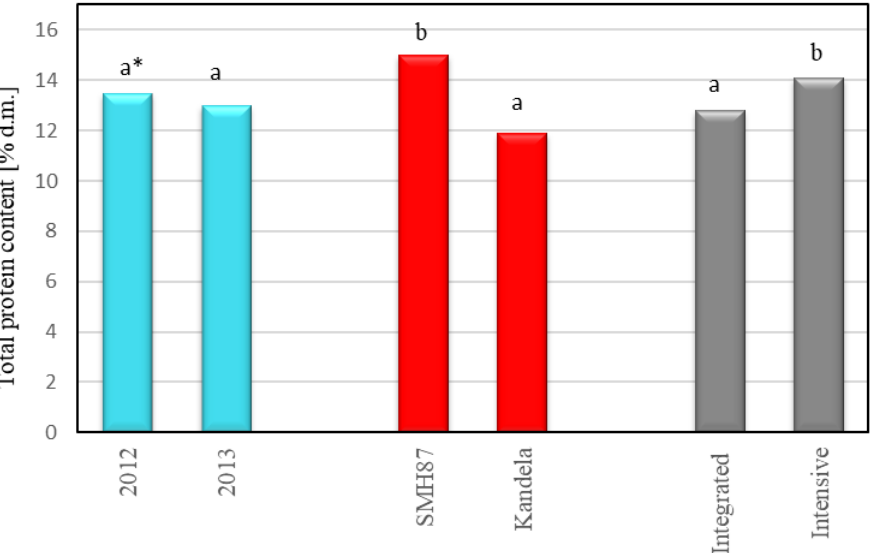
Figure 2. Total protein content of wheat grains in relation to harvest year, cultivar and production technology. * Different letters (a, b) are significantly different (α = 0.05). technology. * Different letters (a, b) are significantly different ( α =